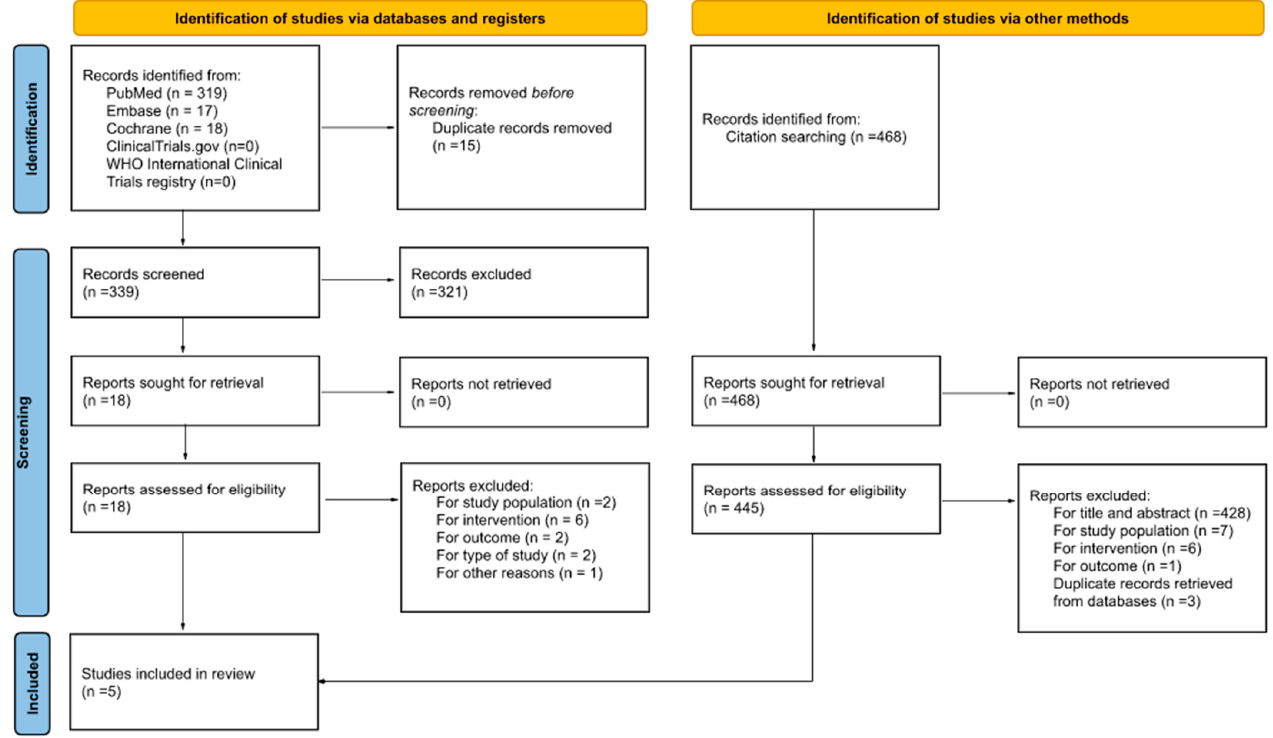
Figure 1. A flow diagram of the search and screening process for identifying the